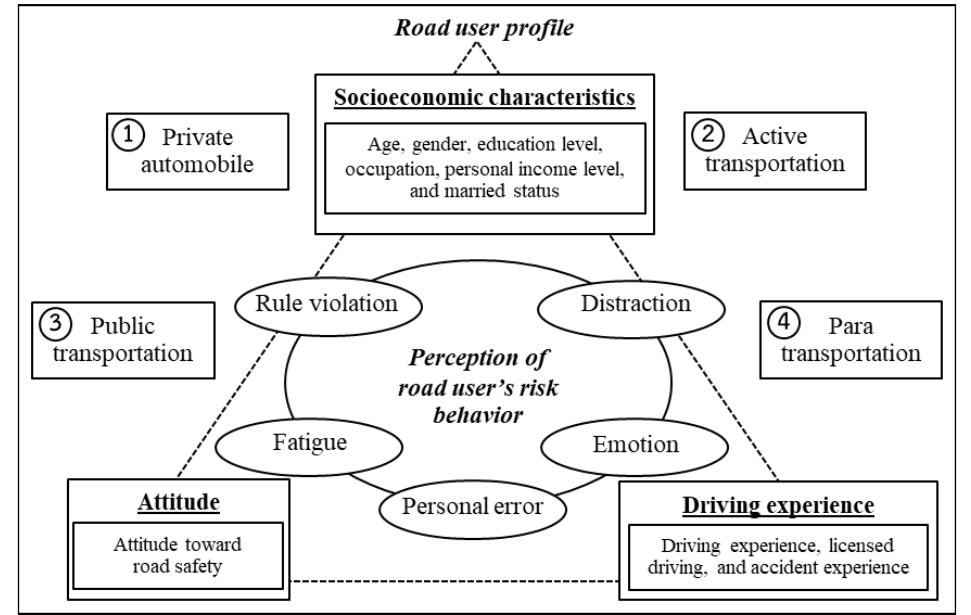
Figure 2. Framework. Figure 2.